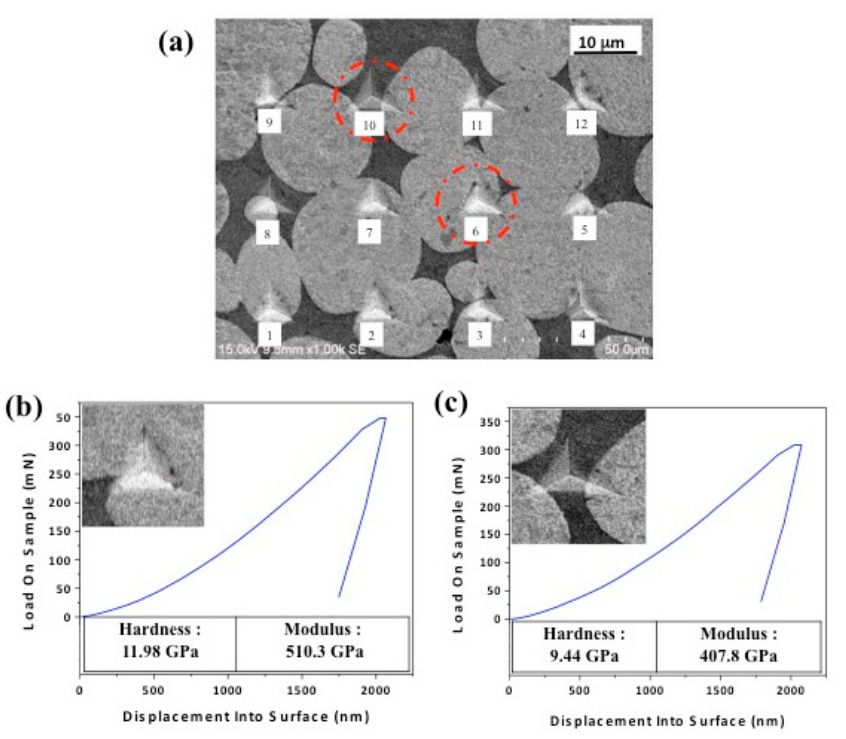
Figure 10. Nanoindentation measurements of the W3Mo model alloy; ( a ) SEM image of 12 indents and the load-displacement curve of ( b ) Indent “6” and ( c ) Indent “10”.